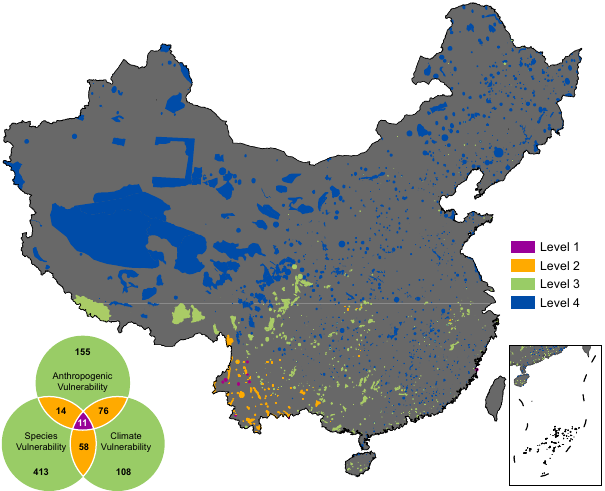
Fig. 4 Classi fi cation of Chinese protected areas (PAs) based on three vulnerability indices: climate vulnerability, anthropogenic vulnerability, and species vulnerability. The PAs in magenta represents the hotspots identi fi ed by all three indices (Level 1), the PAs in orange represents the hotspots identi fi ed by two indices (Level 2) and the PAs in green represents the hotspots identi fi ed by only one index (Level 3). Protected areas that lie outside the hotspots of these three indices are shown in blue (Level 4). Numbers in the Venn diagram are the total number of protected areas in each